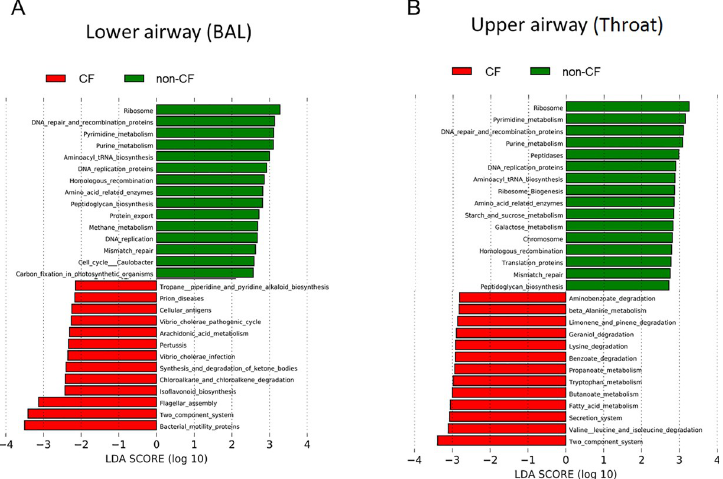
Fig 6. Differentially abundant gene functions comparing CF and non-CF metagenomes in (A) lower and (B) upper airways. Functional categories of genes of the airway metagenome were predicted using PICRUSt, and differentially abundant functions were then identified using linear discriminant analysis (LDA) coupled with effect size measurements (LEfSe). Gene functions enriched in non-CF metagenome are indicated with positive linear discriminant analysis scores (green), and functions differentially enriched in CF metagenome are indicated with negative linear discriminant analysis scores (red).